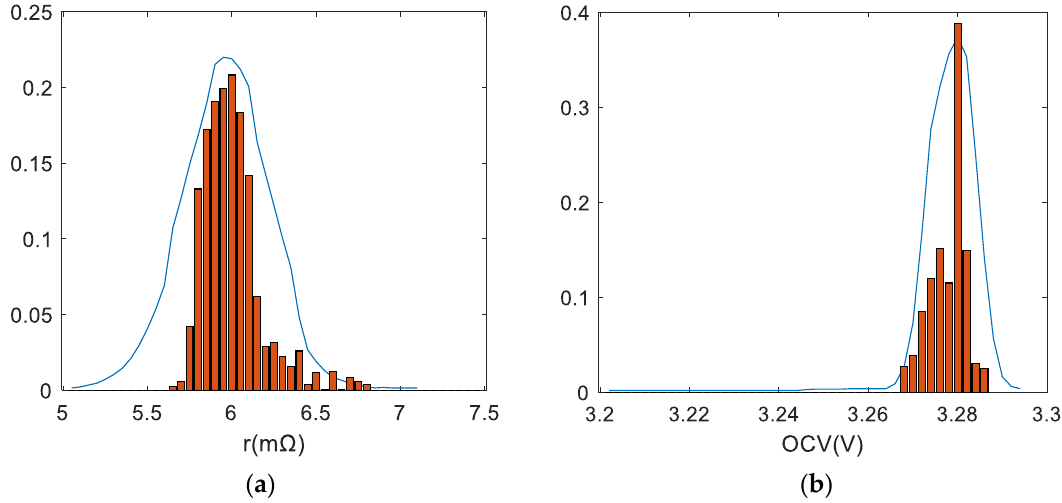
Figure 12. ( a ) Statistical distribution curve of open-circuit voltage for a group of cells; ( b ) Statistical distribution curve of internal resistance of a group of cells.